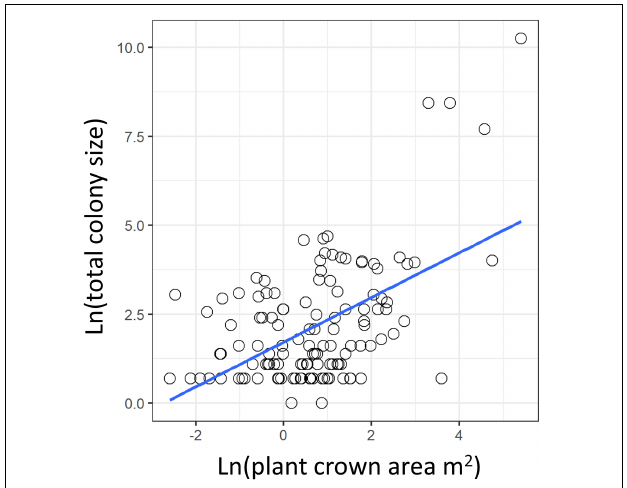
FIGURE 2 | The correlation between substrate size (plant crown area) and the total number of spiders in the